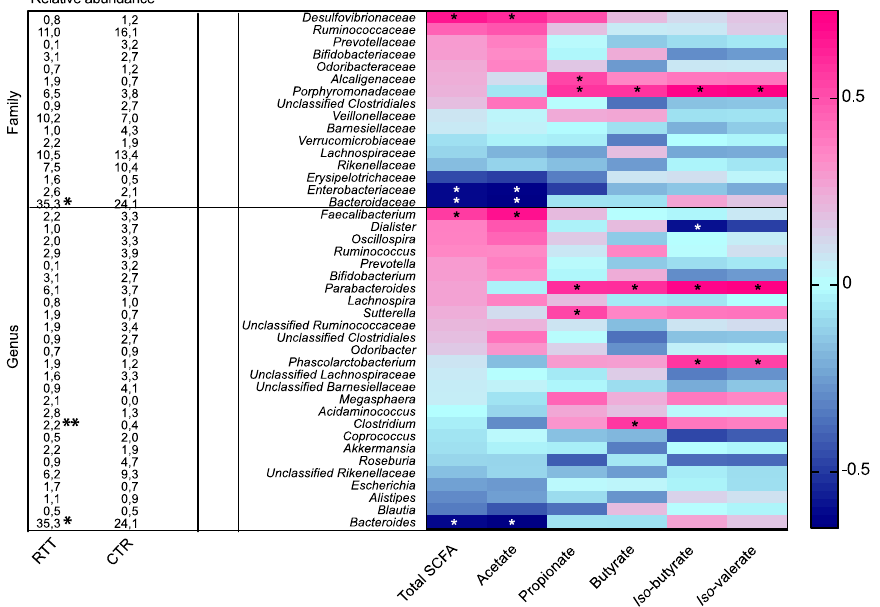
Figure 5. Correlations between intestinal family- and genus-level phylogenetic groups and fecal short-chain fatty acids (SCFAs) (heatmap). Right panel: correlations between intestinal bacteria and SCFAs are indicated by colors (magenta: positive; blue: negative). Asterisks (*) indicate statistically significant correlations ( p < 0.05); Left panel: mean relative abundances in RTT and CTR are reported. Significant differences are indicated by * p < 0.05, and ** p < 0.01, Mann–Whitney test.